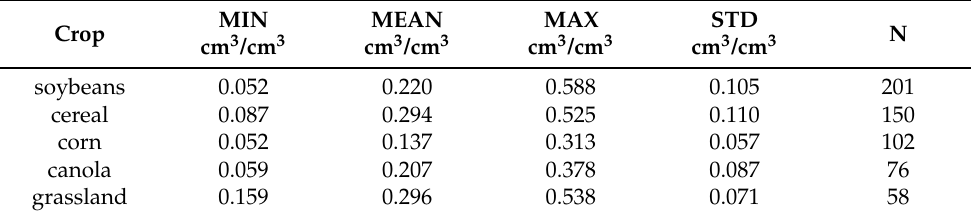
Table 2. Statistical parameters for the minimum (MIN), mean (MEAN), maximum (MAX), standard deviation (STD), and the number of measurements (N) of the in situ SSM.